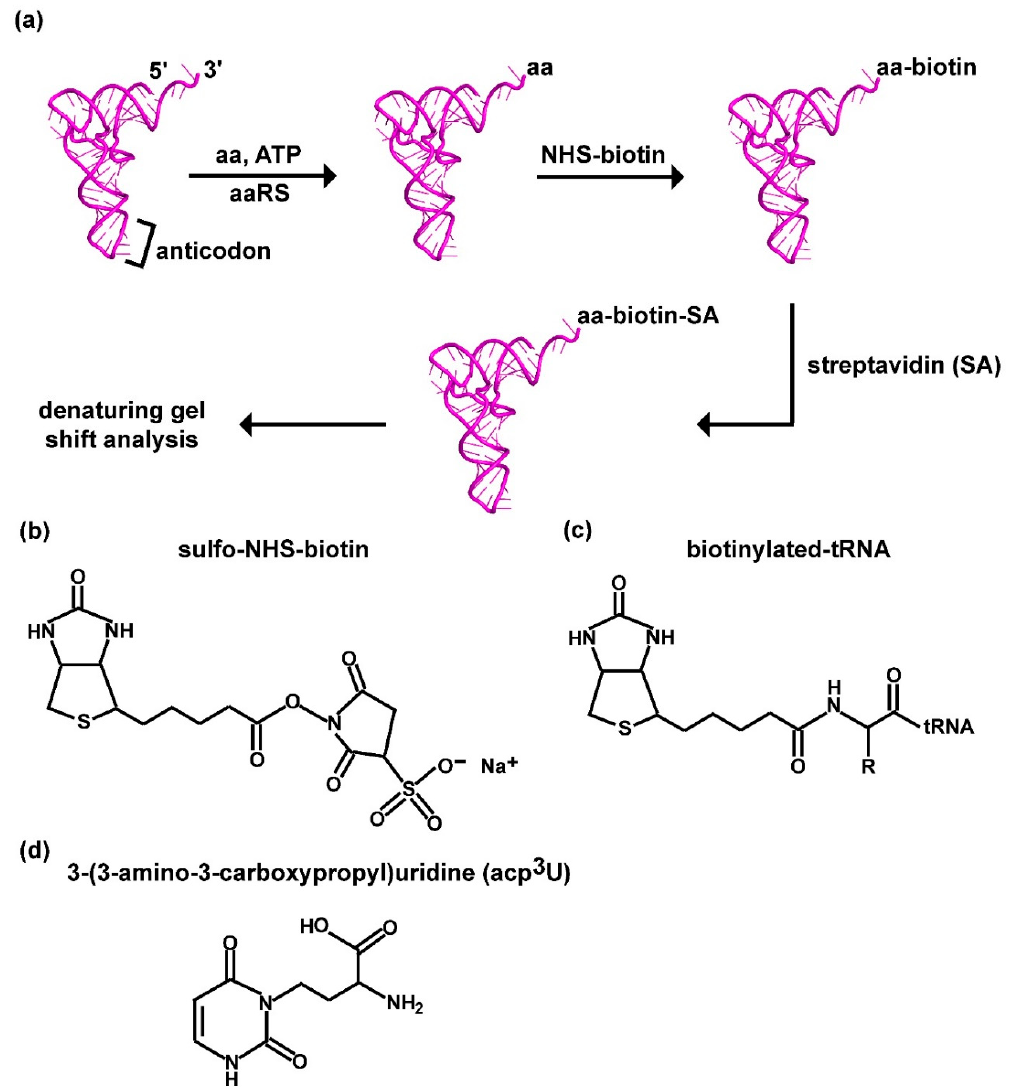
Figure 1. A label-free assay for aminoacylation of tRNA based on biotin-SA conjugation to the aminoacyl group. ( a ) A scheme of the label-free assay, starting with aminoacylation of tRNA catalyzed by an aaRS in the presence of an amino acid and ATP, followed by biotinylation of the aminoacyl group in the aa-tRNA, SA conjugation to biotin, and denaturing PAGE/7M urea gel to separate the product from the unreacted tRNA. ( b ) Chemical structure of sulfo-NHS-biotin. ( c ) Chemical structure of biotinylation to the aminoacyl group of an aa-tRNA, where R is the side chain of the amino acid. ( d ) Chemical structure of acp 3 U in tRNA, showing the presence of a primary amine that would be reactive to biotin. Abbreviations: aa: amino acid; SA: streptavidin; acp 3 U: 3-(3-amino-